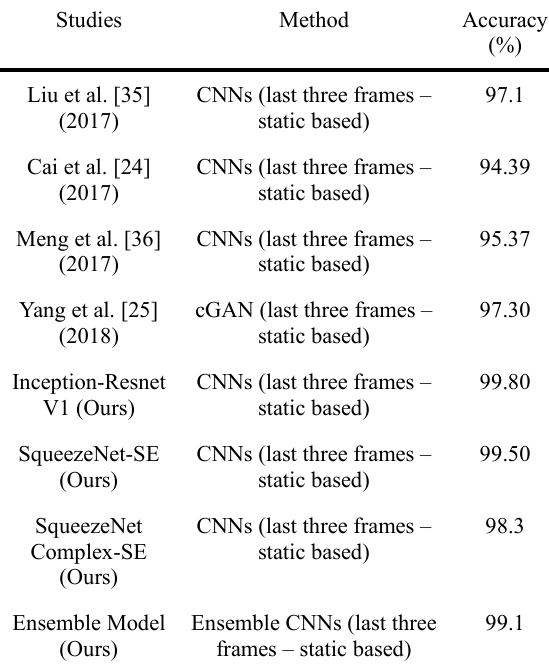
Figure 17. Confusion Matrix for FER2013: (a) SqueezeNet Complex-SE (b) Ensemble Model. Table 3 . Results of 7 expressions on the CK+ dataset.